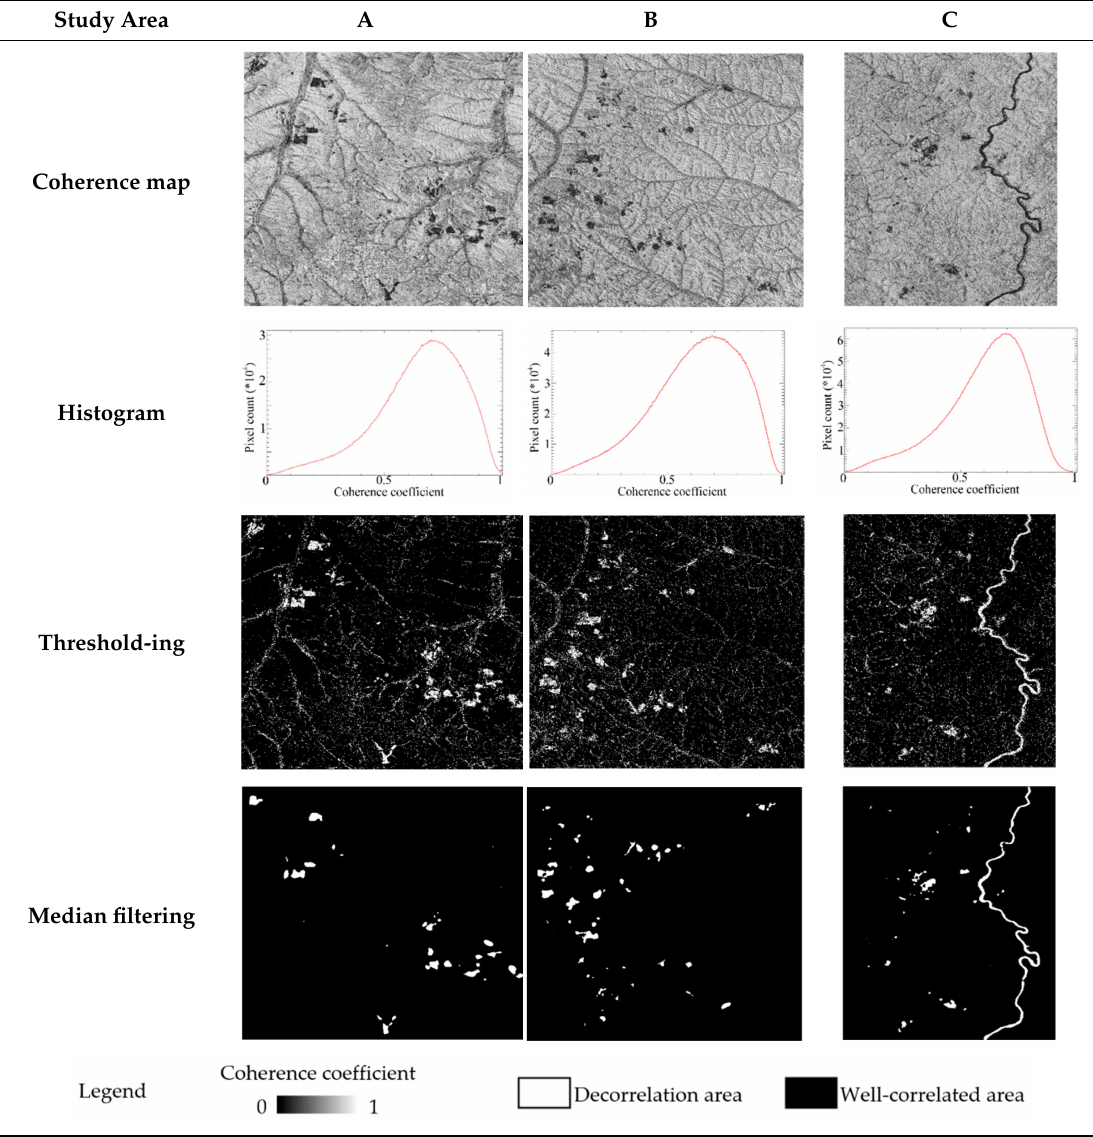
Table 2. Refining process for coherence maps of the study